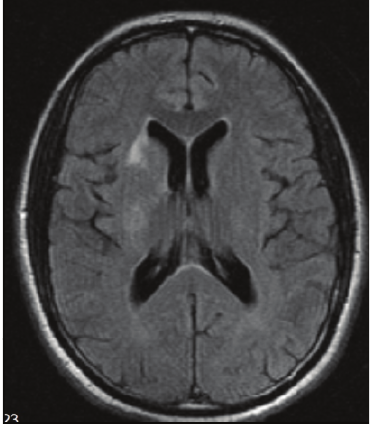
Figure 1: Brian MRI without gadolinium shows right anterior corona radiata and basal ganglia acute infarction.